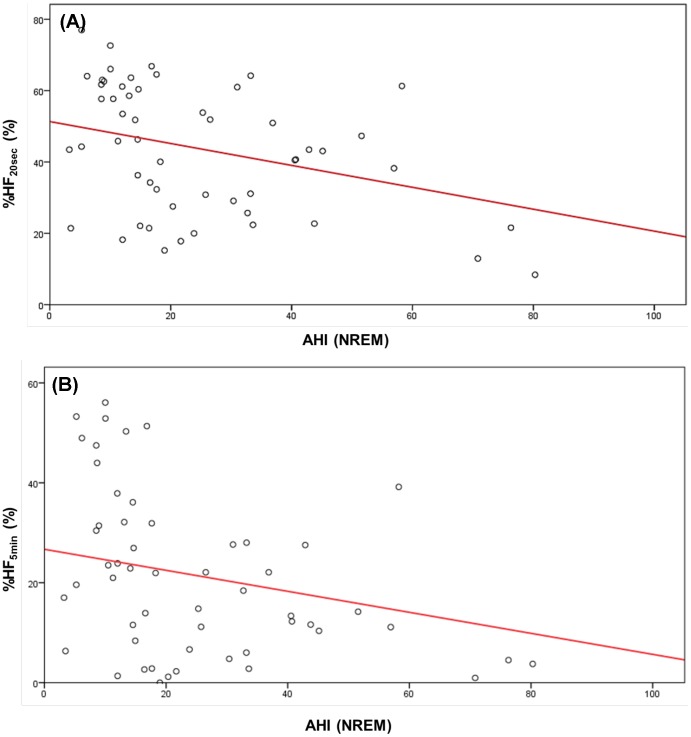
Impacts of AHI on the stability of parasympathetic nerve function during NREM in females.(A): Effect of AHI on %HF20sec. The partial correlation coefficient between AHI and %HF20sec was –0.407 (p = 0.003). Red line: regression line. (B): Effect of AHI on %HF5min. The partial correlation coefficient between AHI and %HF5min was –0.268 (p = 0.040). Red line: regression line.